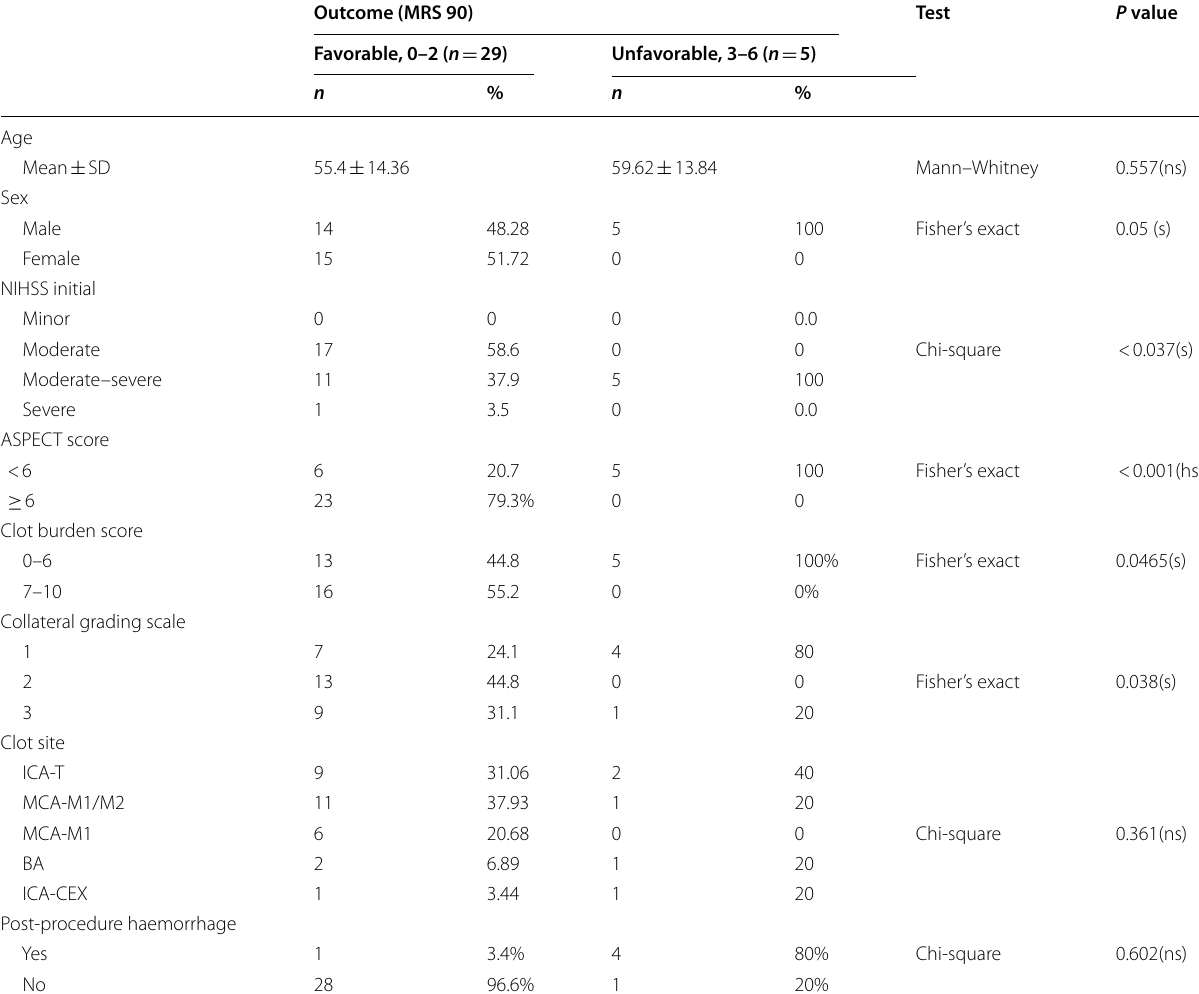
Table 2 Predictors of clinical outcome data ( n